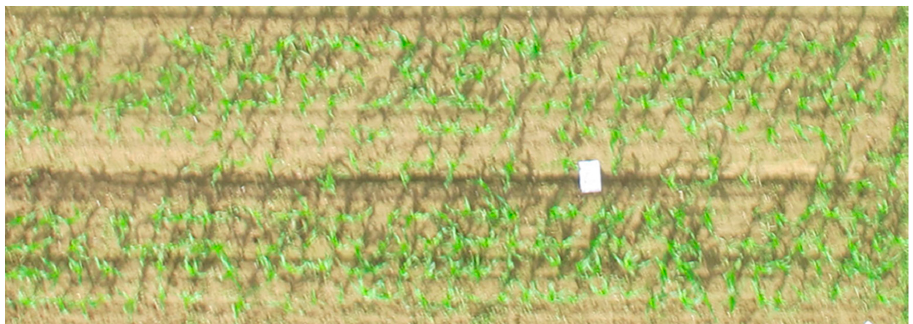
Figure 3. Nadir view of an RGB image acquired with a drone from an equidistantly planted plot.